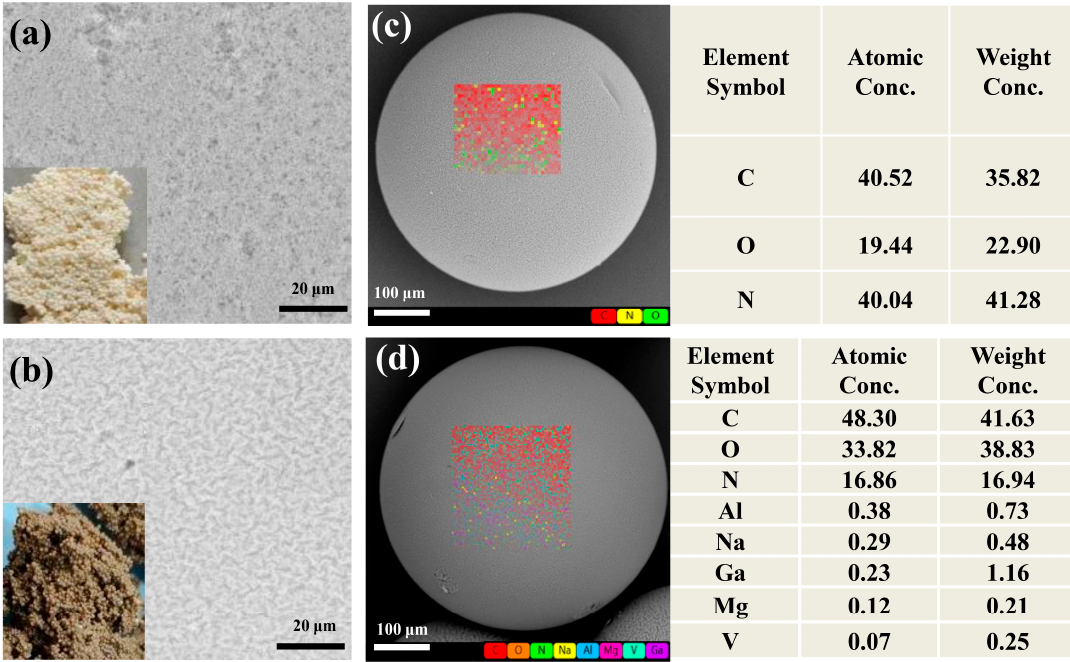
Figure 1. Pictures and SEM images of ( a ) PAC-resin and ( b ) WAC-resin; and EDS of ( c ) PAC-resin and ( d ) WAC-resin.